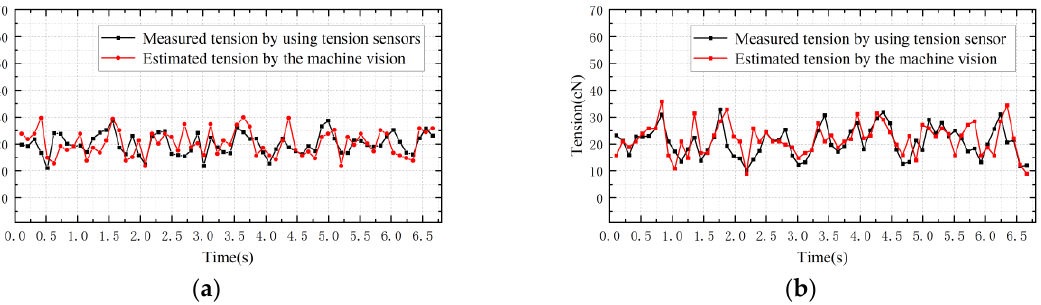
Figure 14. The sampling period is 0.104 s. ( a ) Motor speed is 100 r/min. ( b ) Motor speed is 150 r/min. Table 1. Relative error in machine vision detection. Tension Estimated Using Machine Tension Measured Using Tension Sensor (cN)